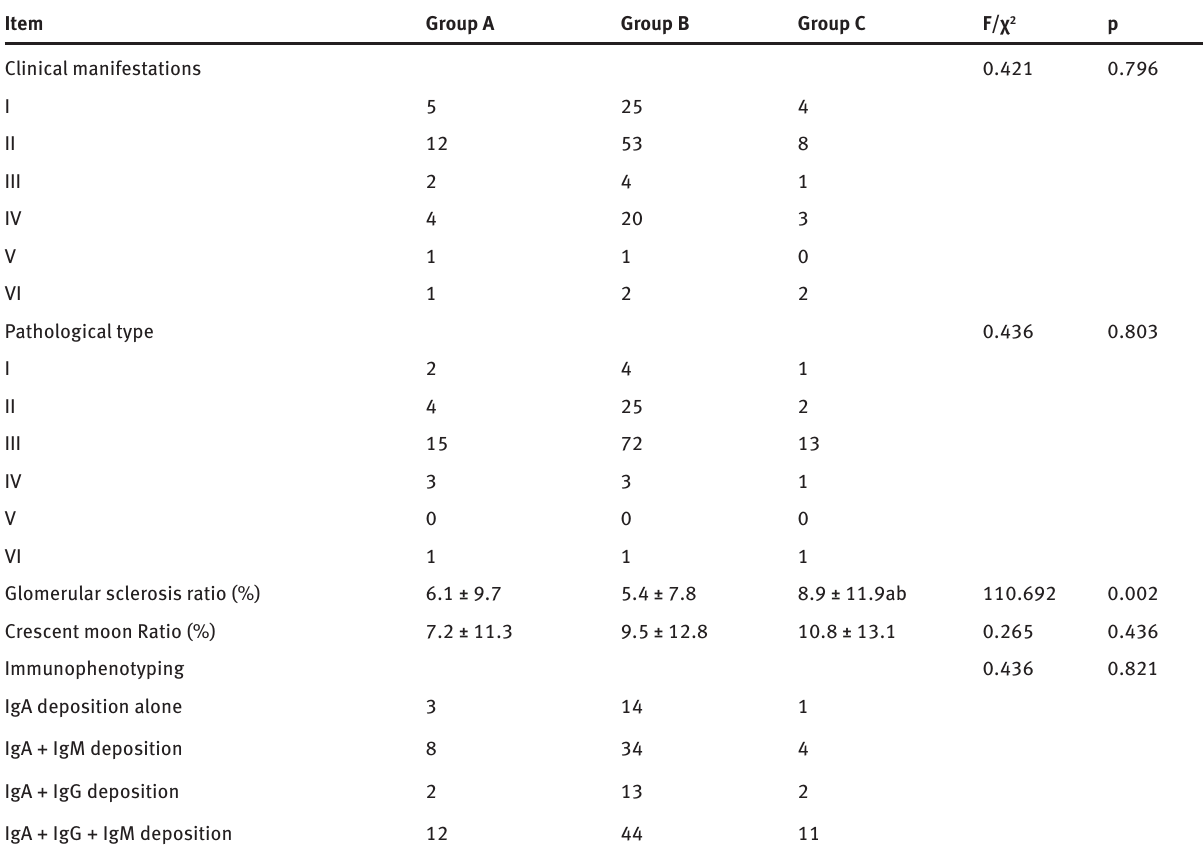
Table 2: Comparison of clinical manifestations and pathological types in each group.